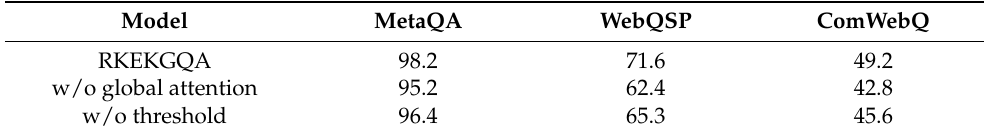
Table 6. Ablation study on MetaQA.